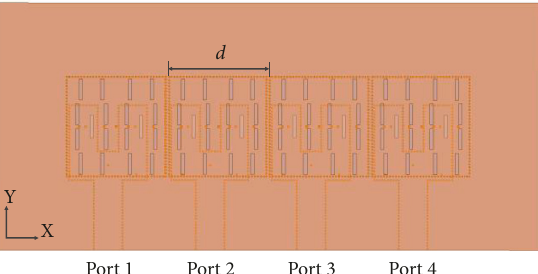
Figure 8: Structure of 1 × 4 antenna array.